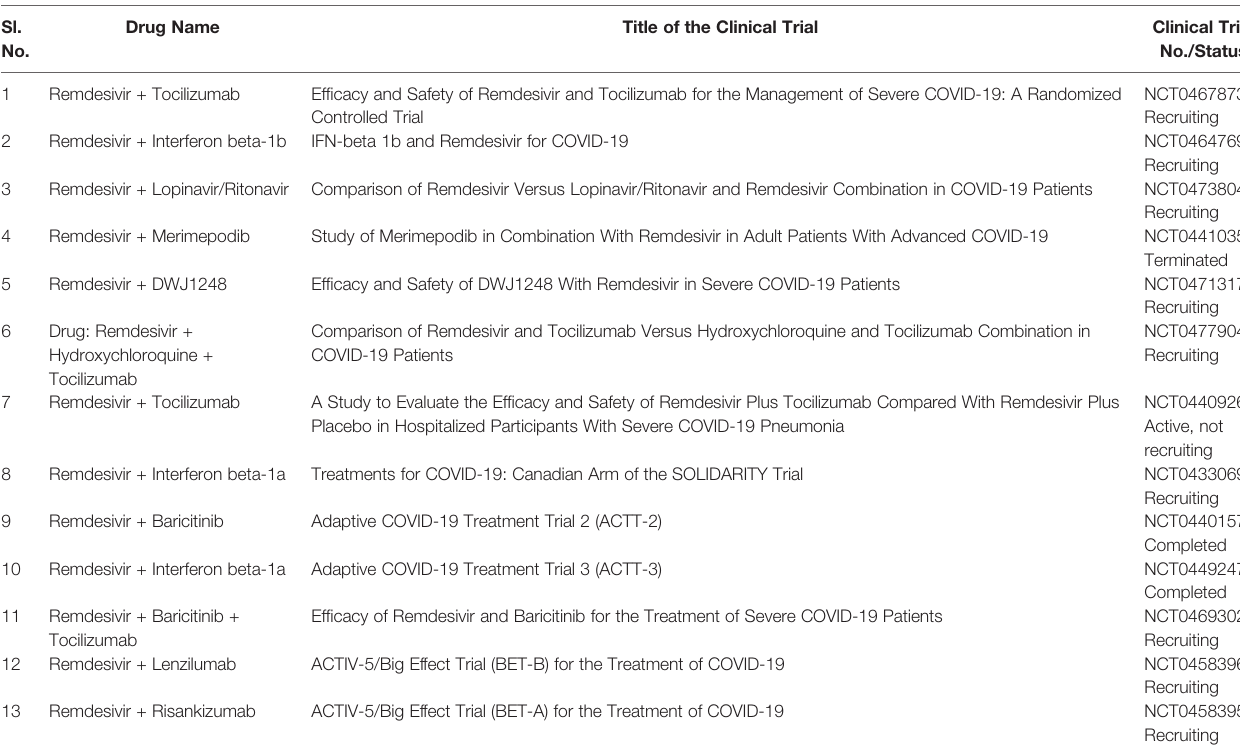
TABLE 1 | Remdesivir in combination with repurposed drugs as potential COVID-19 therapeutics. Sl.